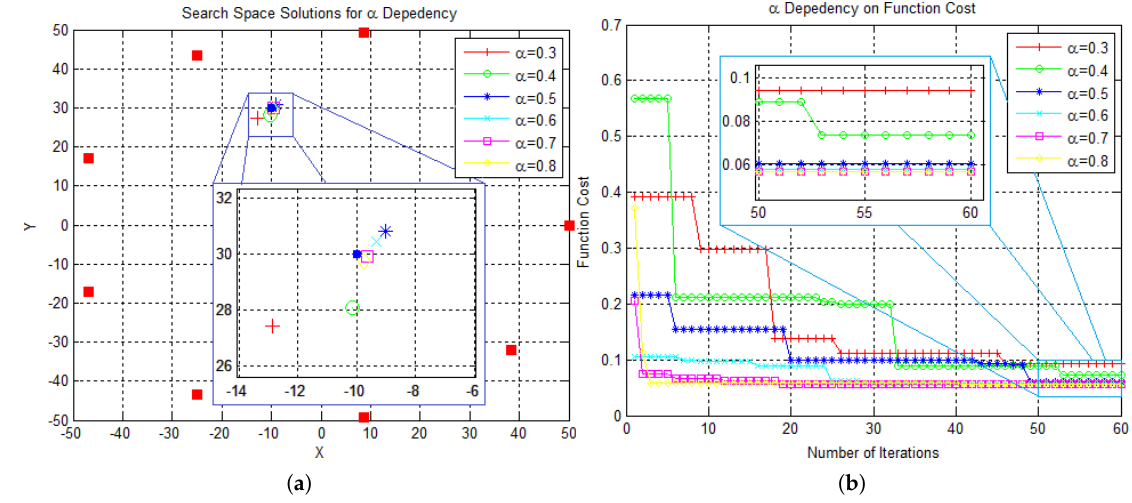
Figure 2. Parameter α Dependency Analysis. ( a ) Representation of the final solutions in search space; “ • ” denotes the true source location. ( b ) Convergence dependency on α in function